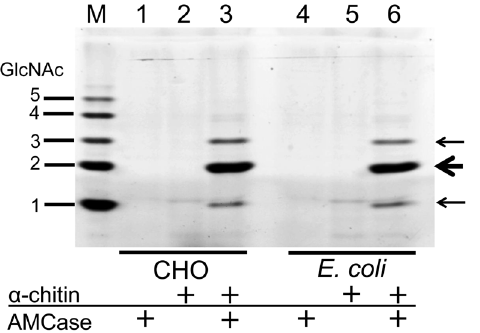
Figure 6. Degradation products of colloidal chitin by CHO- and E.coli -expressed mouse AMCase. Colloidal chitin was used as a substrate to determine the chitinase activity of CHO-expressed or E. coli -expressed protein in 0.1 M Gly-HCl buffer. Reactions were conducted for 1 h at 37 u C. The chitin fragments generated by the recombinant AMCase proteins were analyzed by fluorophore-assisted carbohydrate electrophoresis [14,32]. Chitin oligomers are shown in the left margin. Fluorophore-assisted carbohydrate electrophoresis analysis revealed that the recombinant mouse AMCase releases mainly